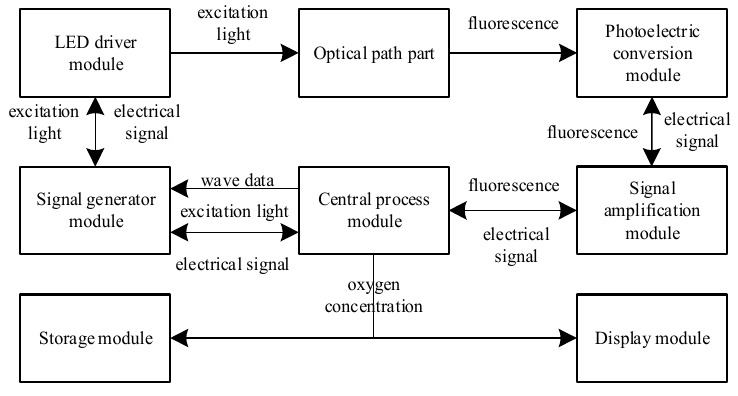
Figure 3. System block diagram of fiber optic oxygen sensor.